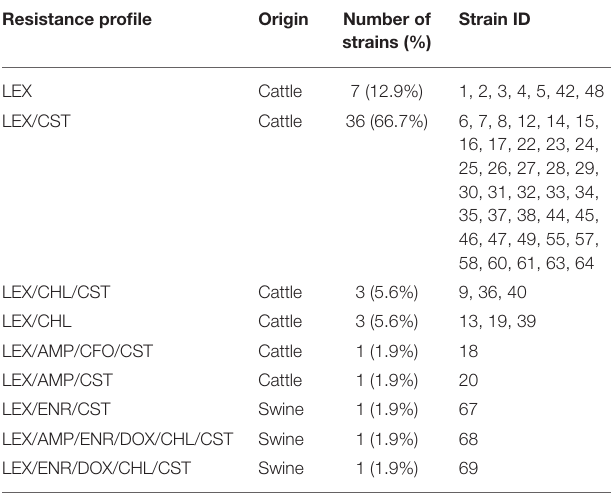
TABLE 3 | Phenotypic resistance profiles detected in STEC strains isolated from cattle and